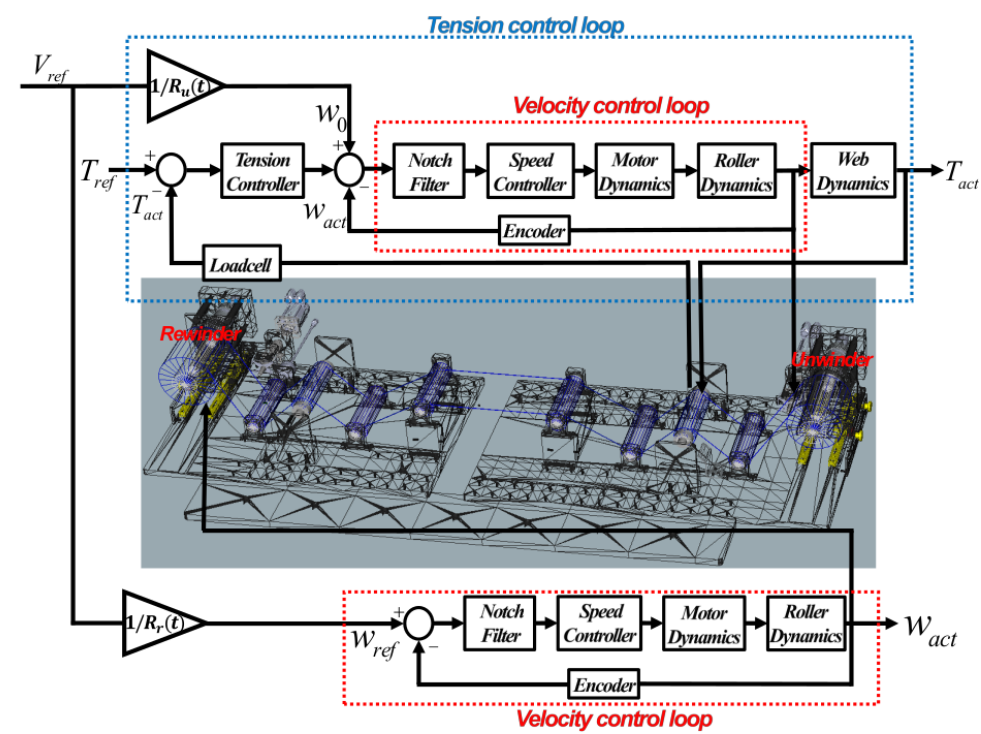
Figure 4. The entire control block diagram in the R2R